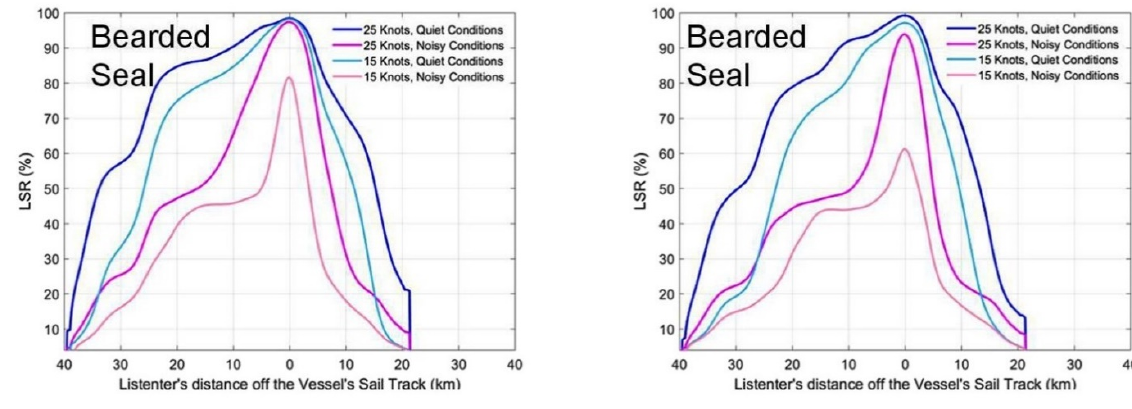
Figure 4. Modelled LSR (%) from a container (left) and cruise ship (right) at 15 and 25 knots under both quiet and noisy noise conditions (Pine et al.,